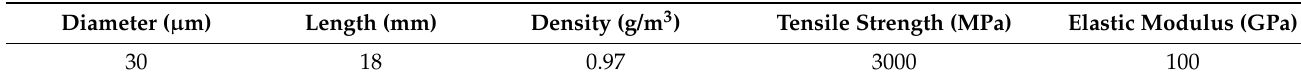
Table 2. Properties of PE fiber.